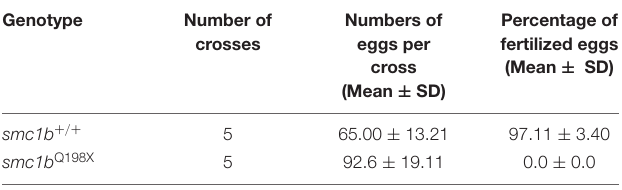
TABLE 3 | Smc1b mutant males are